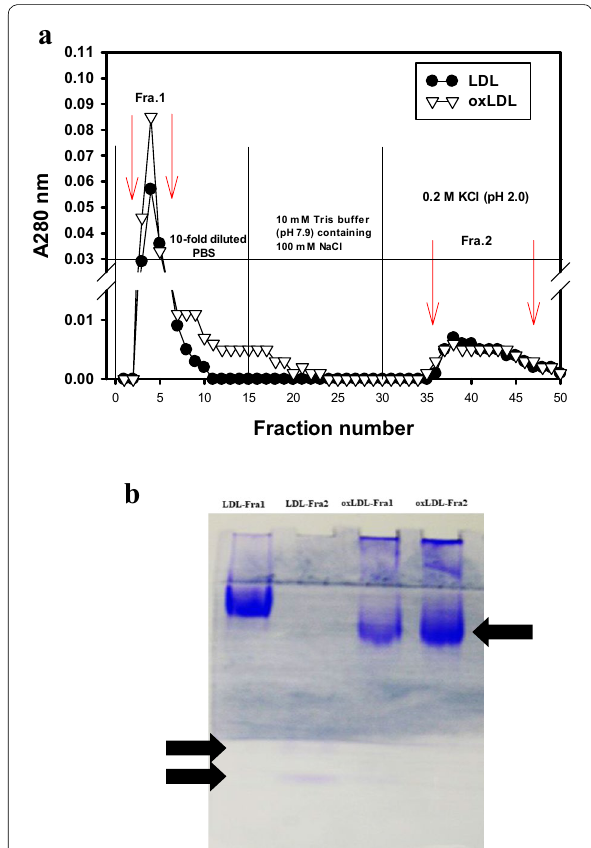
Fig. 3 a Chromatograms of LDL or oxLDL on a SPTIs‑Sepharose affinity column. Fraction 1 (Fra.1) was the unbound portion of LDL or oxLDL washed by tenfold‑diluted PBS, and the fraction 2 (Fra.2) was the bound portion of LDL or oxLDL eluted by 0.2 M KCl (pH 2.0), and b the protein stains in the native PAGE gel with two layers of separation gels for LDL‑Fra1, oxLDL‑Fra1, LDL‑Fra2, and oxLDL‑Fra2. Arrows indicated the unidentified components from